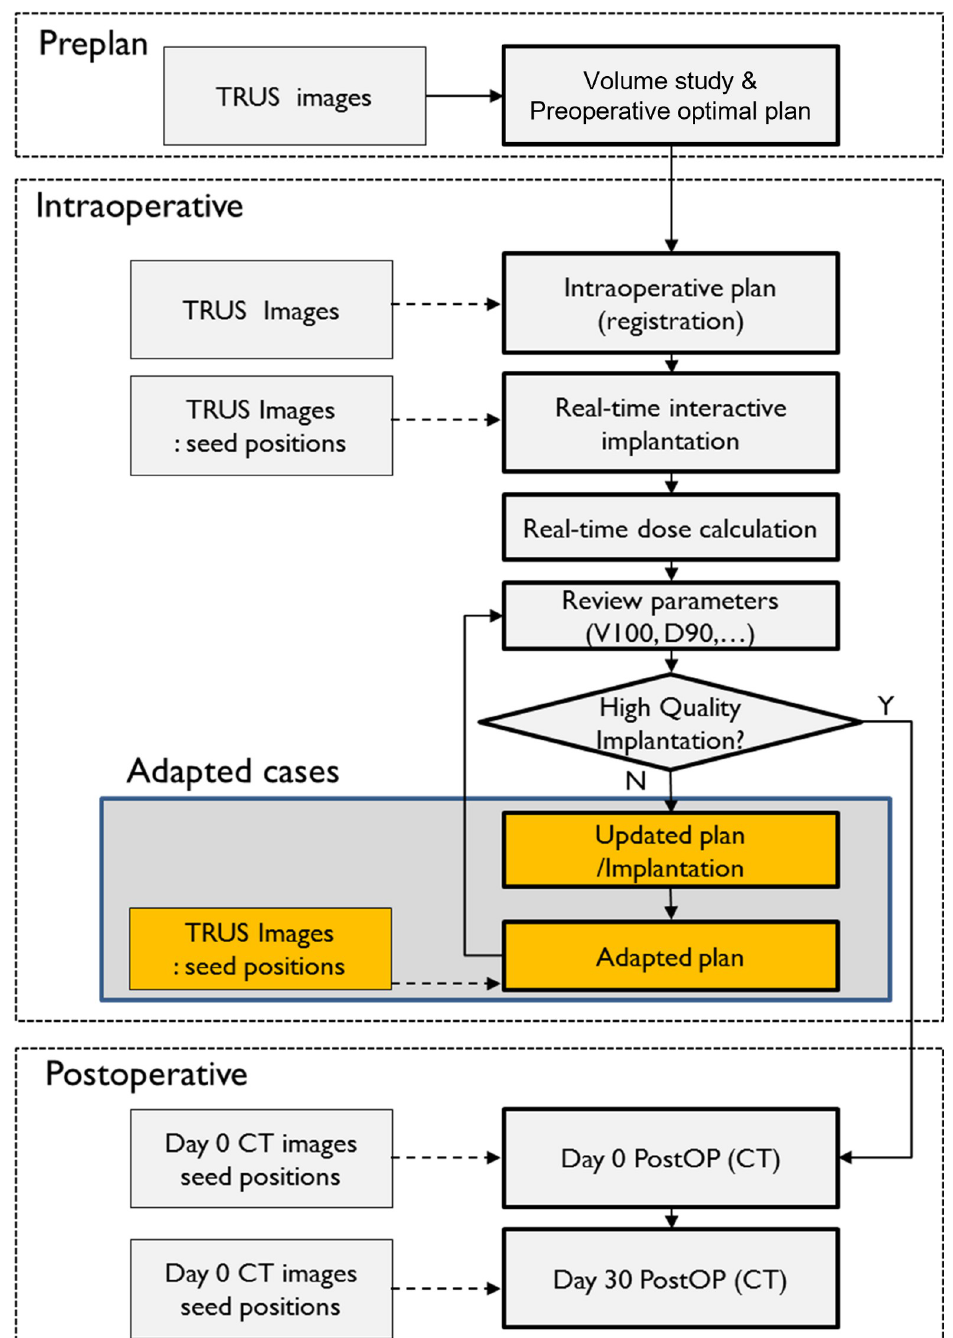
Fig 1. The schematics describe the procedure of low-dose-rate prostate brachytherapy. First, preoperative planning is conducted based on the transrectal ultrasound (TRUS) images. Intraoperatively, the TRUS images are acquired to verify the reproducibility of the prostate, urethra, bladder, and rectum between the preplan and intraoperative procedure and to monitor the needle and the seeds. After seed implantation, TRUS-based dosimetry is performed. When the target coverage was not sufficient, intraoperative optimization was conducted immediately. On postoperative day 0, dosimetry was conducted using computed tomography images. Further, on postoperative day 30, dosimetry was conducted for monitoring seed